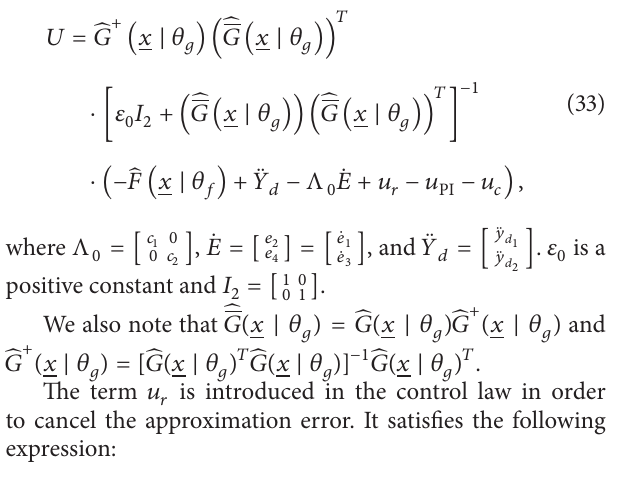
Figure 12: The sliding surfaces 𝑠 1 and 𝑠 2 .